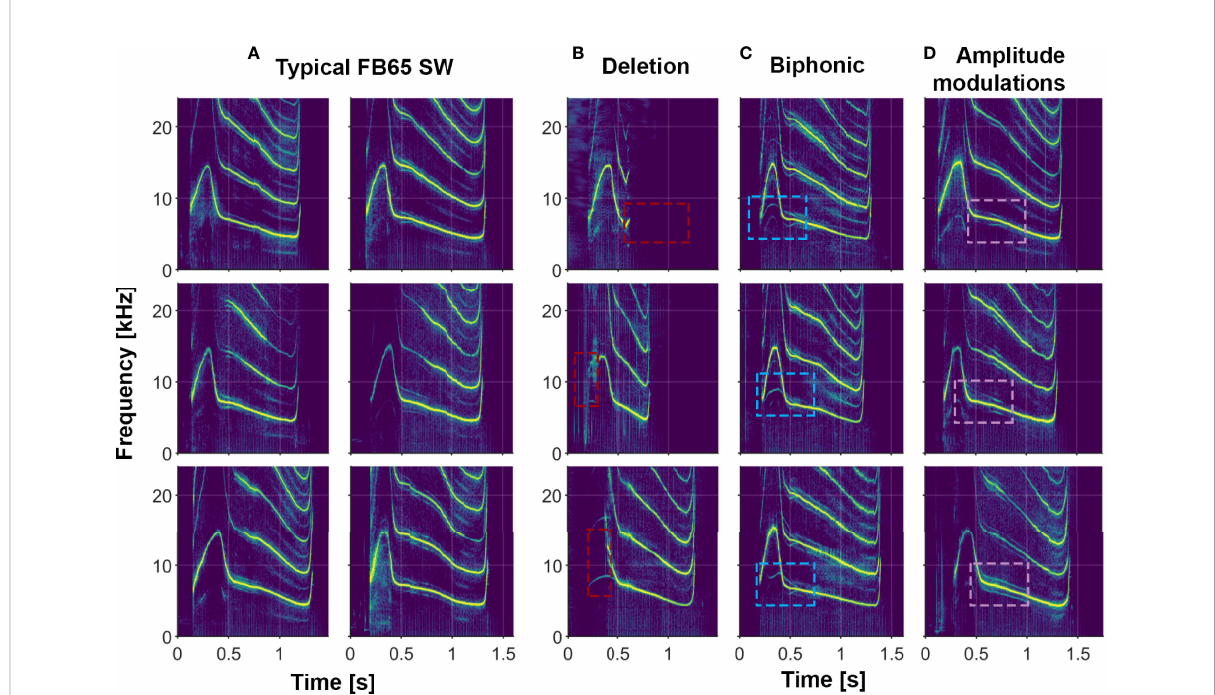
FIGURE 4 Examples of several whistle features in the signature whistles of a single animal (FB65). (A) Typical signature whistles; (B) Deletions where part of the signature whistle is omitted (marked by red boxes); (C) Biphonic vocalizations where a second independent contour is produced (marked by blue boxes); (D) Amplitude modulations that result in subtle spectral sidebands on either side of the fundamental frequency contour (marked by purple